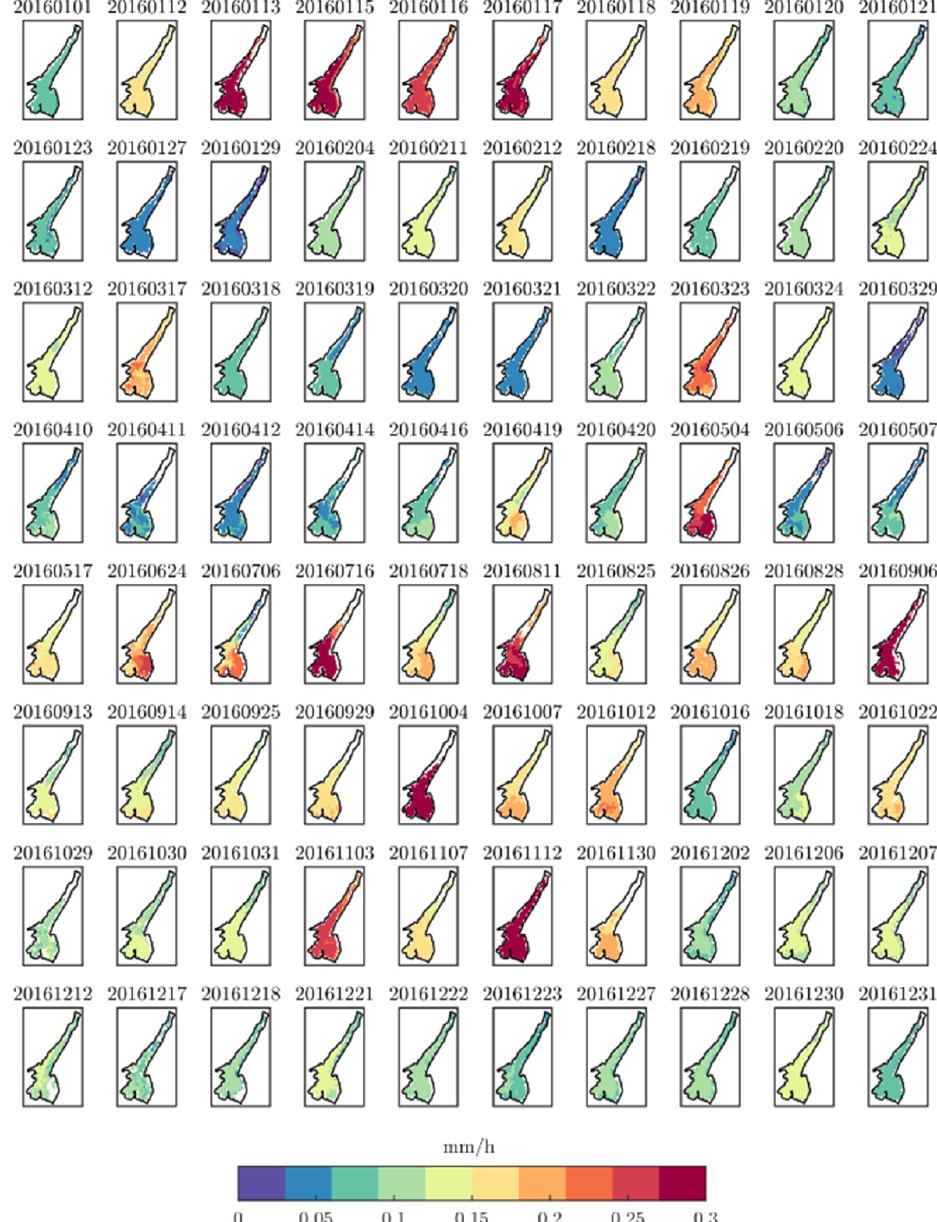
Figure 4. Instantaneous evaporation ( E h ) maps for Lake Garda obtained from the year 2016 estimated with the LakeVap tool fed by CCI-Lakes LSWT maps and WRF (spatially averaged) meteorologi- cal